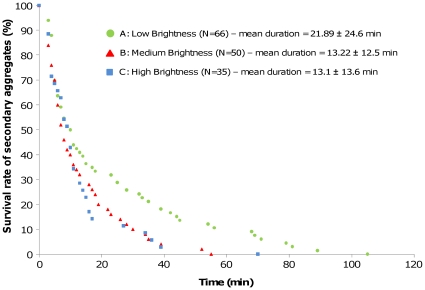
Survival rate of secondary aggregates observed in low, medium and high brightness (respectively, experimental conditions A, B and C).Total number of secondary aggregates observed and means duration of these aggregates are given in the legend of the figure for each experimental condition (means ± SD). Log Rank test showed significant difference between Low brightness and both other situations (p<0.05).